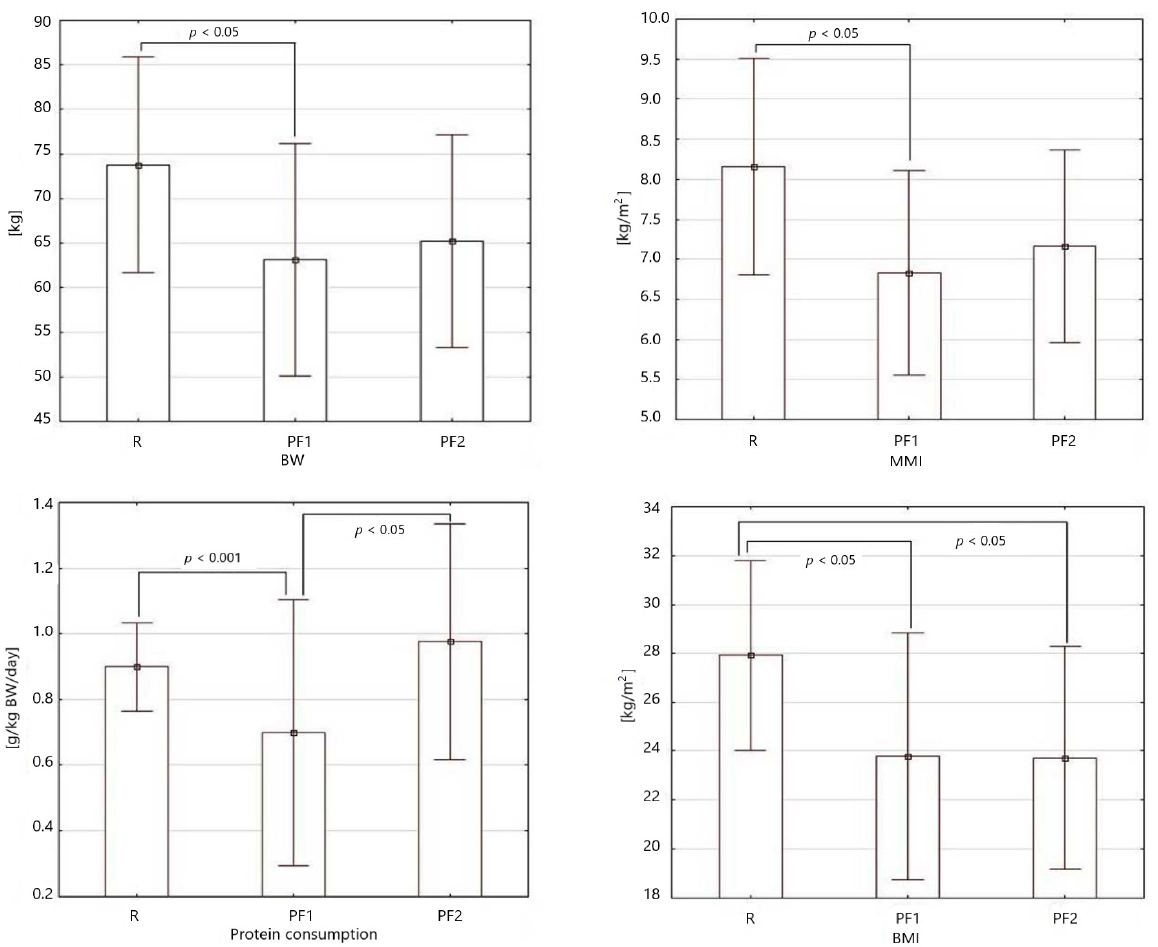
Figure 1. Bar graphs of body weight (BW), muscle mass index (MMI), protein consumption, and BMI among robust (R), pre-frail at baseline (PF1), and pre-frail patients at the end of the study (PF2), showing statistical differences according to post hoc analysis.